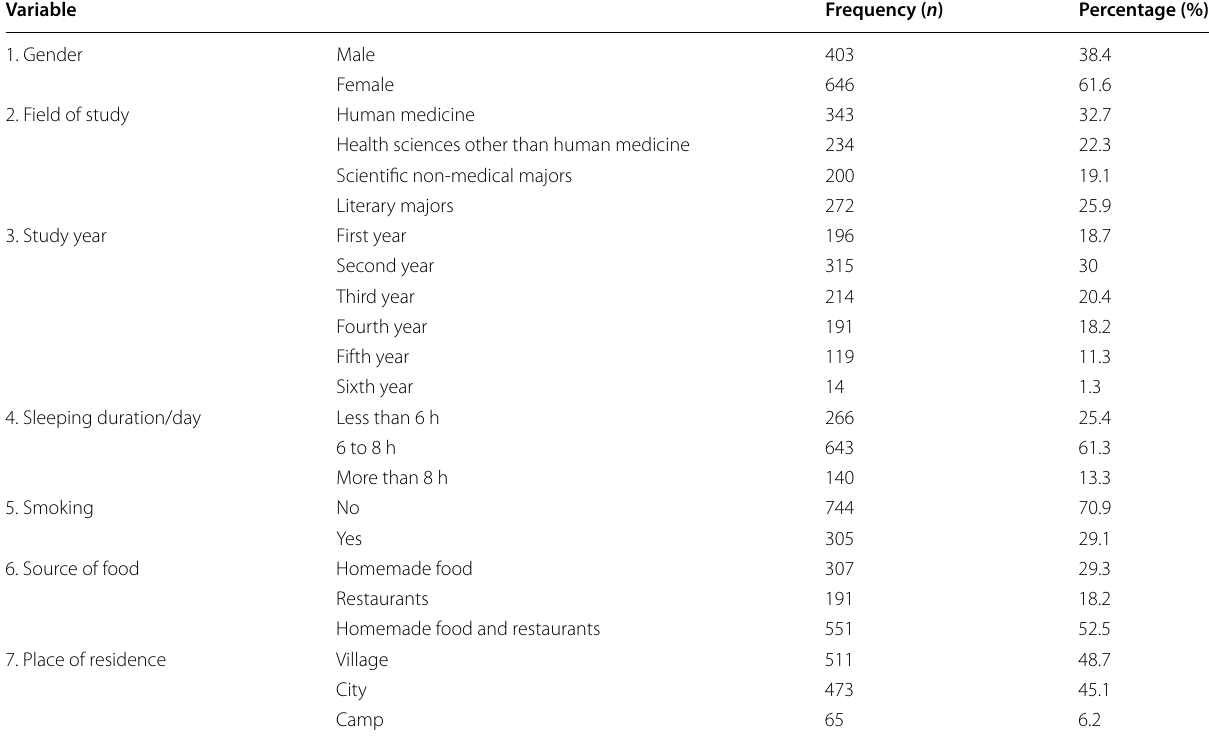
Table 1 Descriptive statistics of the sample characteristics ( n